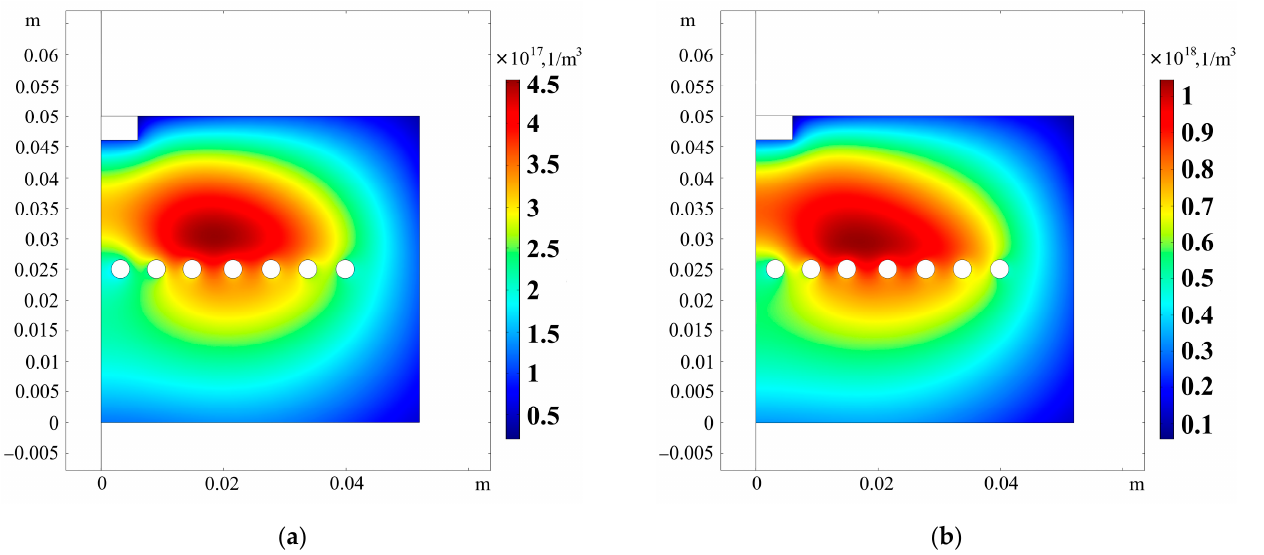
Figure 7. Two-dimensional distribution of charged particle density over the DC volume in the case of using an internal antenna with flat arrangement of turns: ( a ) xenon flow rate of 0.5 mg/s, RF power of 86 W, extracted ion current of 140 mA; ( b ) xenon flow rate of 1 mg/s, RF power of 143 W, extracted ion current of 300 mA.